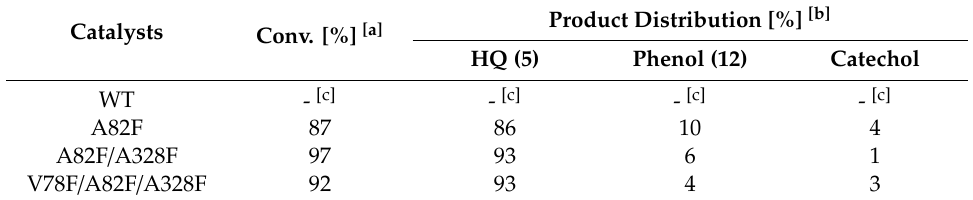
Table 1. Chemo- and regioselective dihydroxylation of benzene with almost exclusive formation of HQ using the respective P450-BM3-containing E. coli resting cells.